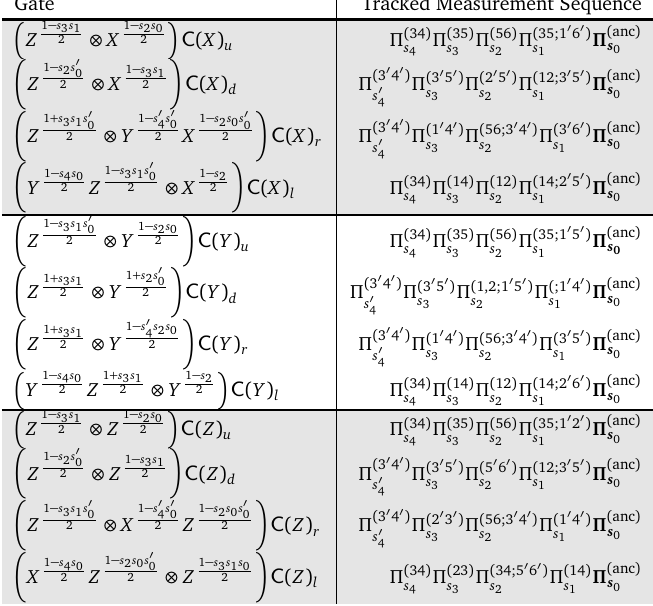
Table 10: Pauli gate corrections tracked for the corresponding controlled-Pauli gates implemented using Majorana-Pauli tracking methods. The implicit action 1 − s (cid:48) ns (cid:48) 0 1 − sns 0 Π ( 34 ) ⊗ X Π ( 3 (cid:48) 4 (cid:48) ) on the two ancillary qubits is X for sequences of length n . 2 2 s 0 s (cid:48) 0 (When there is not a final projector for one of the ancillary pairs, it is equavalent to there being a projector for that ancillary pair onto its initial projection channel, = s = s (cid:48) e.g. s or s (cid:48) .) n 0 n 0 Gate Tracked Measurement Sequence